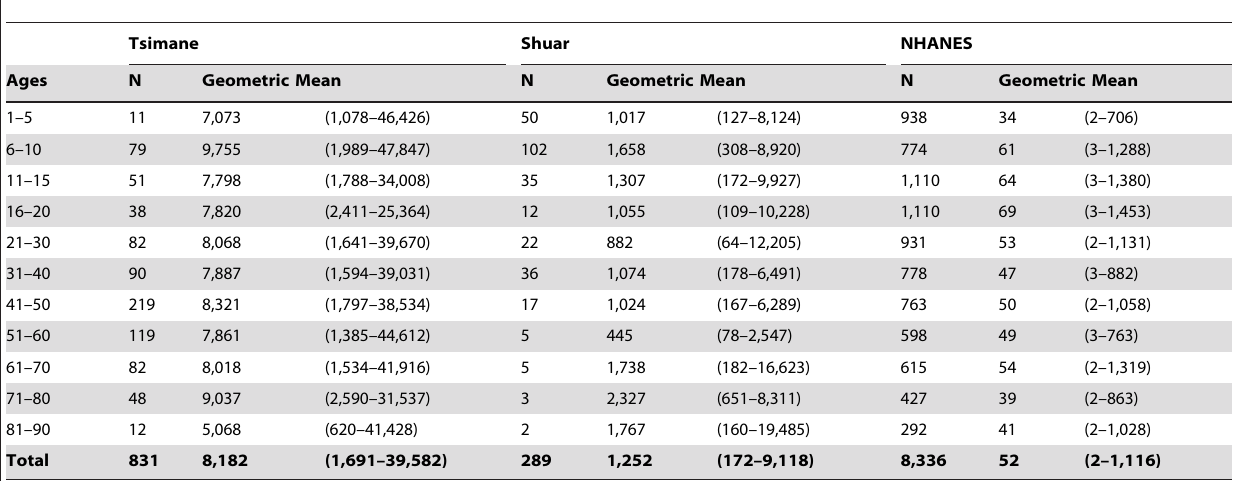
Table 1. Sample sizes and IgE by population and age category.